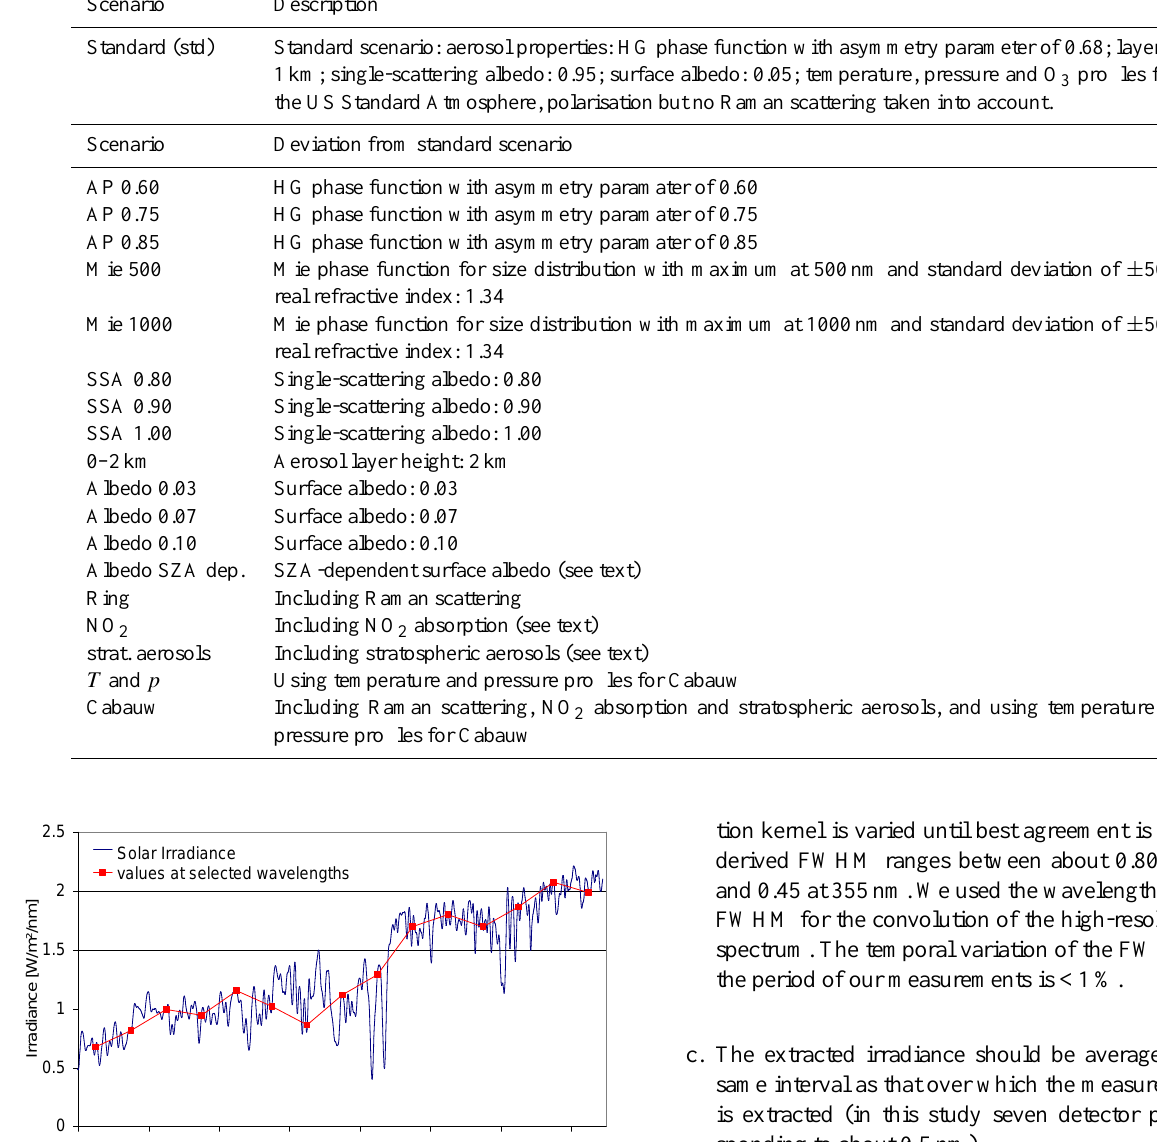
Table 1. Overview on the different scenarios (for detailed description see Sect. 2.2). For all scenarios radiances are simulated for AOD between 0 and 0.5.